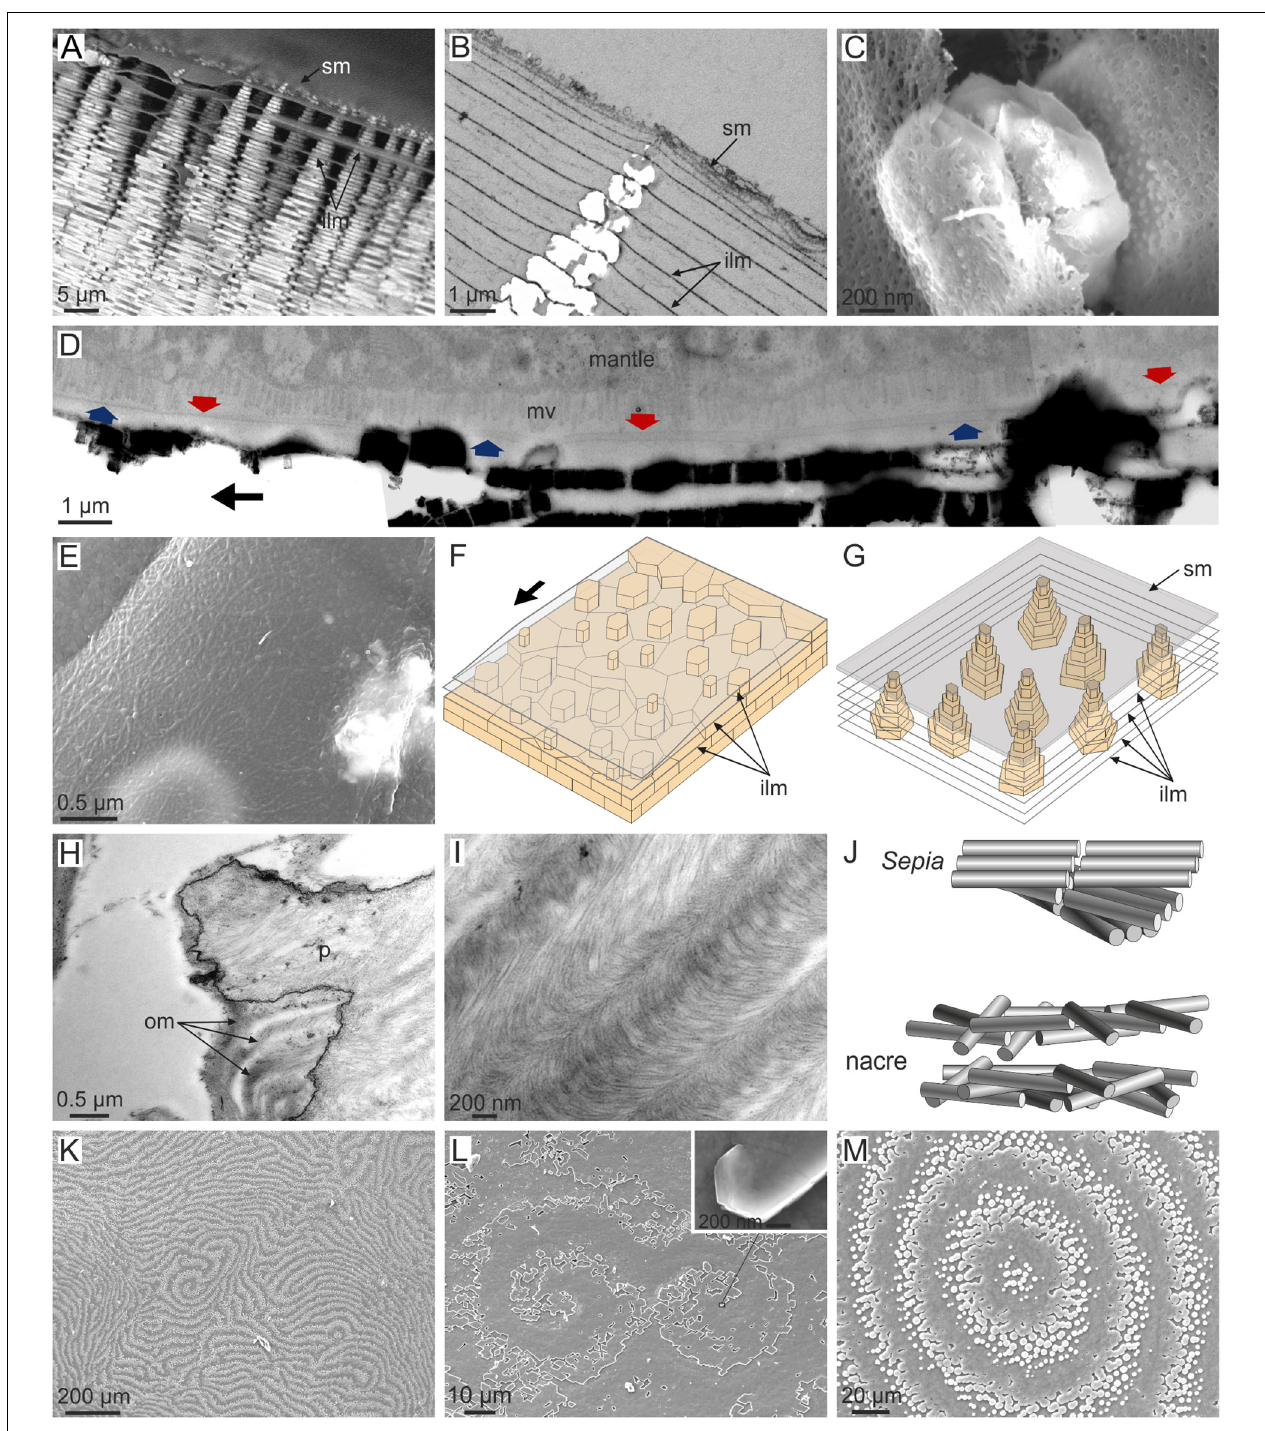
FIGURE 7 | Distribution and structure of interlamellar membranes in gastropod (A–C,G) and bivalve (D–F,K–M) nacre, and comparison to the organic membranes in Sepia (H–J) . (A) Jujubinus pseudogravinae . Typical tower-like arrangement of gastropod nacre, with interlamellar membranes subtending between tablets. The tips of the towers are embedded within the surface membrane. (B) Monodonta labio . TEM section through a tower of tablets and intervening interlamellar membranes. The latter predates the former. (C) Steromphala pennanti . Growing nacre tablets between interlamellar membranes. Note the fibrous nature of the membranes. (D) Pinctada fucata . Section through the mantle and nacre (composite TEM micrograph). The tracings of two interlamellar membranes covering the two most recent lamellae are indicated with arrows in different colors. The membranes become progressively closer in the growth direction (indicated by the black